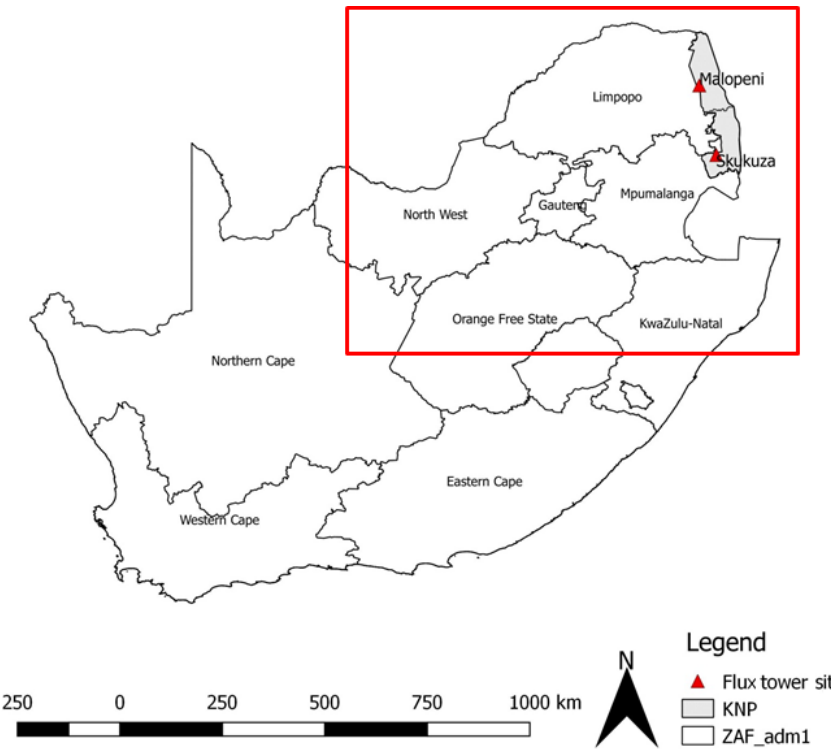
Figure 1. Maps indicating South Africa, Kruger National Park (KNP), flux tower sites (Skukuza and Malopeni) and the area considered for grid inter-comparison (red